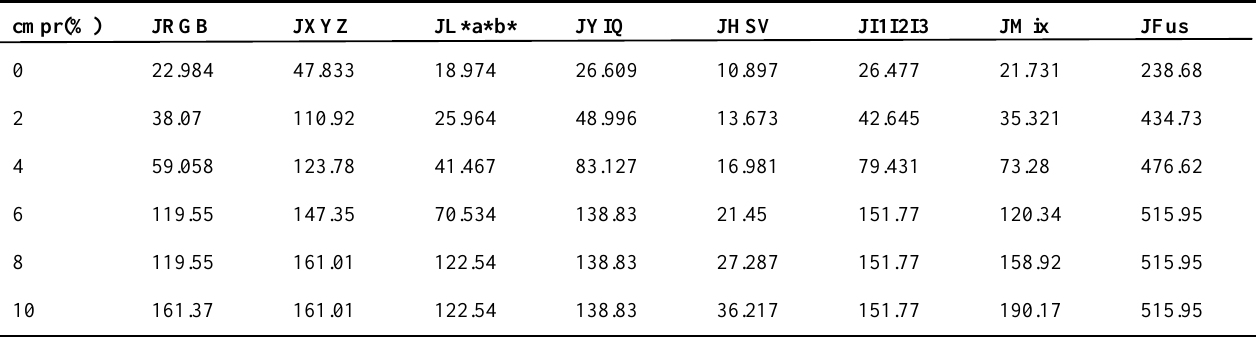
Table 1. LDC scores of all the color spaces under different PCA compression